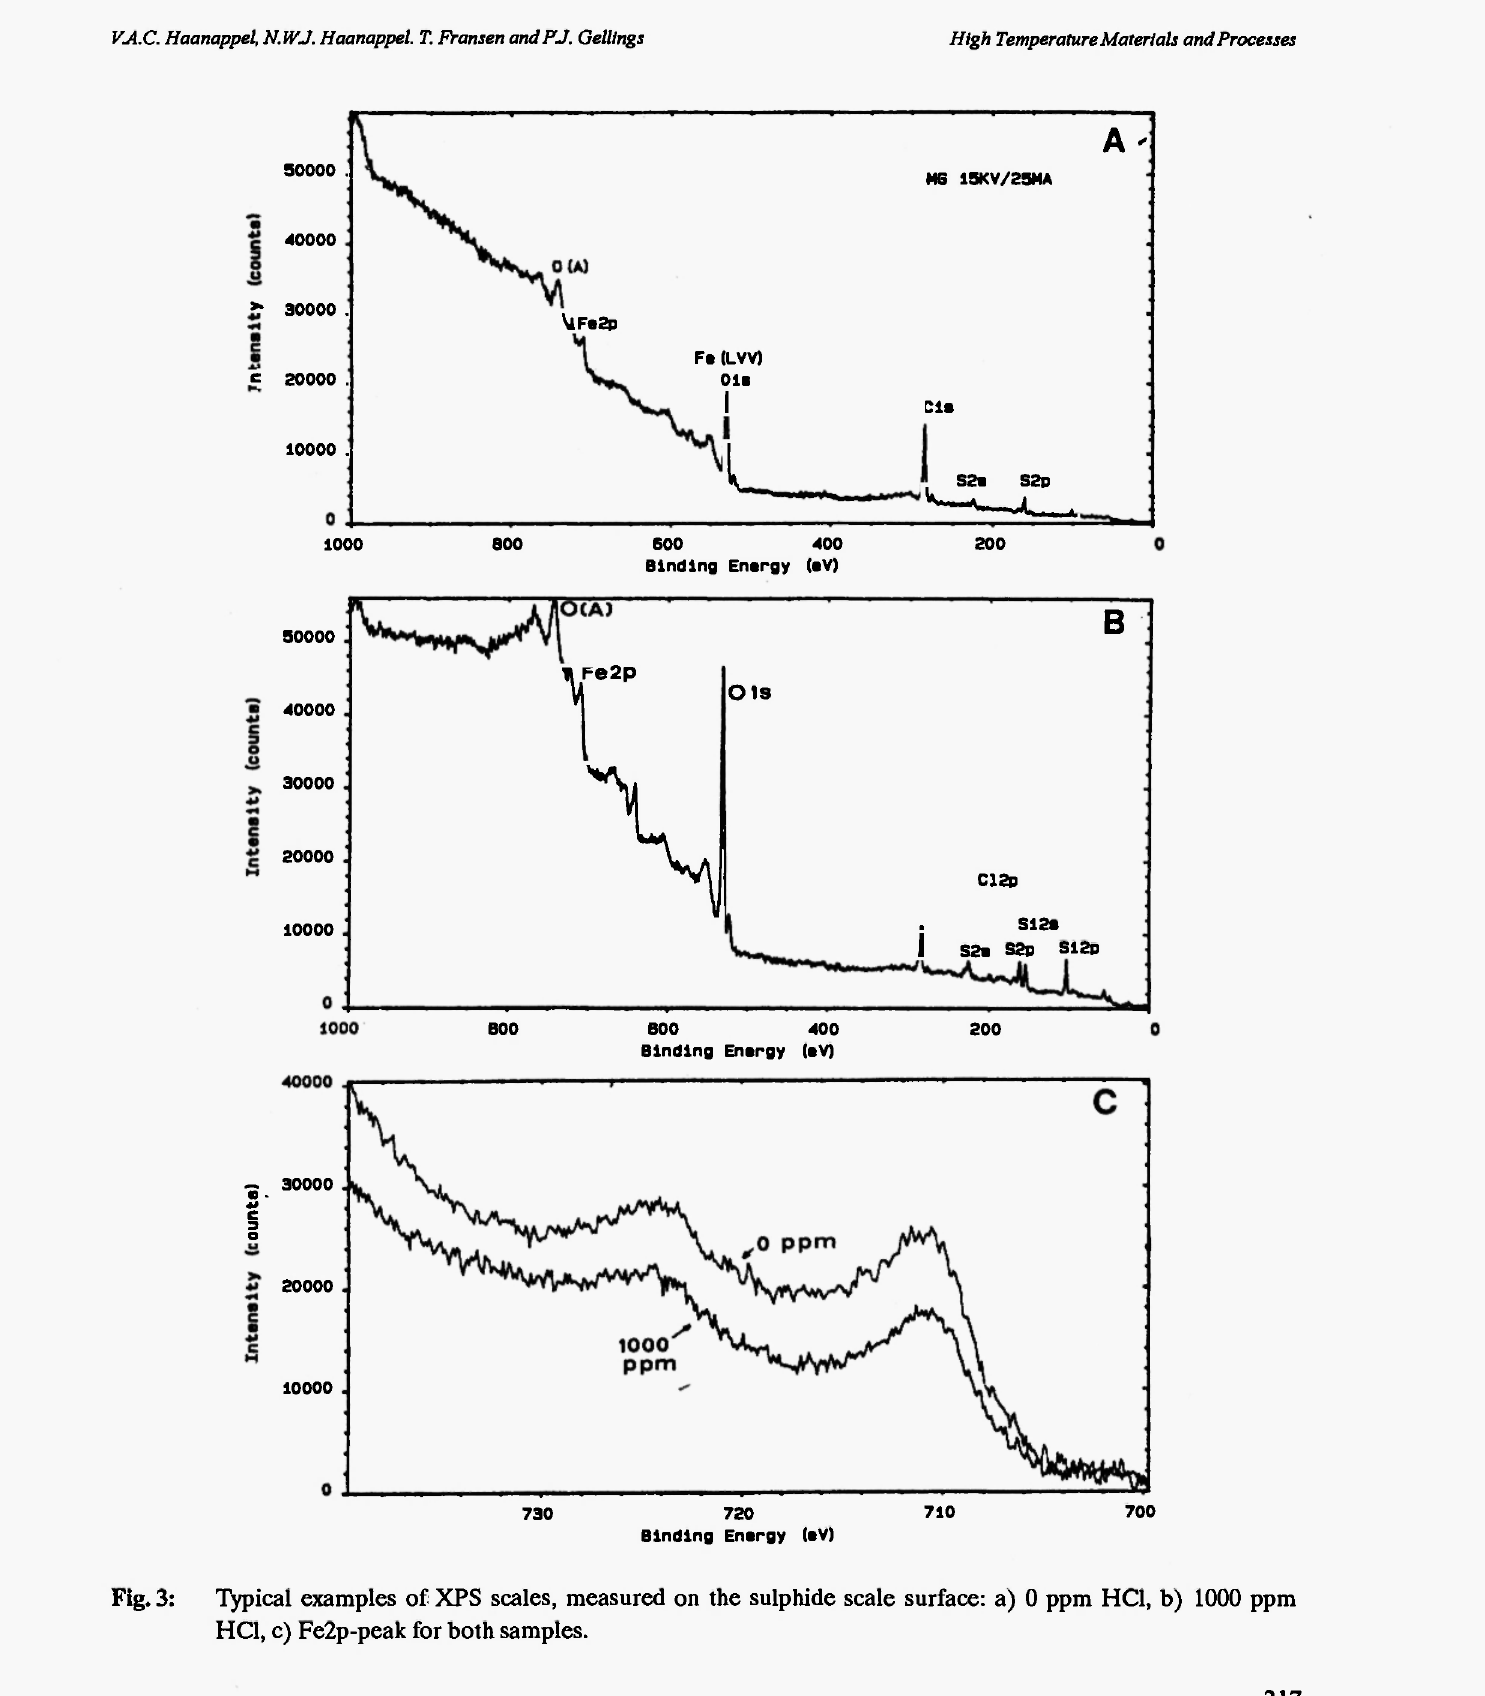
Fig. 3: Typical examples of XPS scales, measured on the sulphide scale surface: a) 0 ppm HCl, b) 1000 ppm HCl, c) Fe2p-peak for both